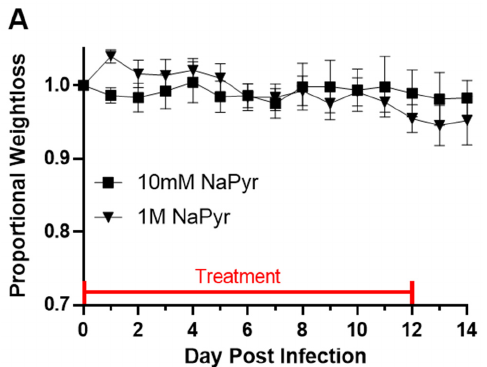
Figure 1. Sodium pyruvate (NaPyr) shows no toxicity in mice. WT C57BL/6J mice were nebulized 3 times daily for 15 min per treatment with 10 mM and 1 M concentrations of NaPyr diluted in phosphate buffered saline (PBS) for 14 days to determine toxicity and weight differences between treatment groups. Data are representative of one experiment with n = 5 mice per treatment group.